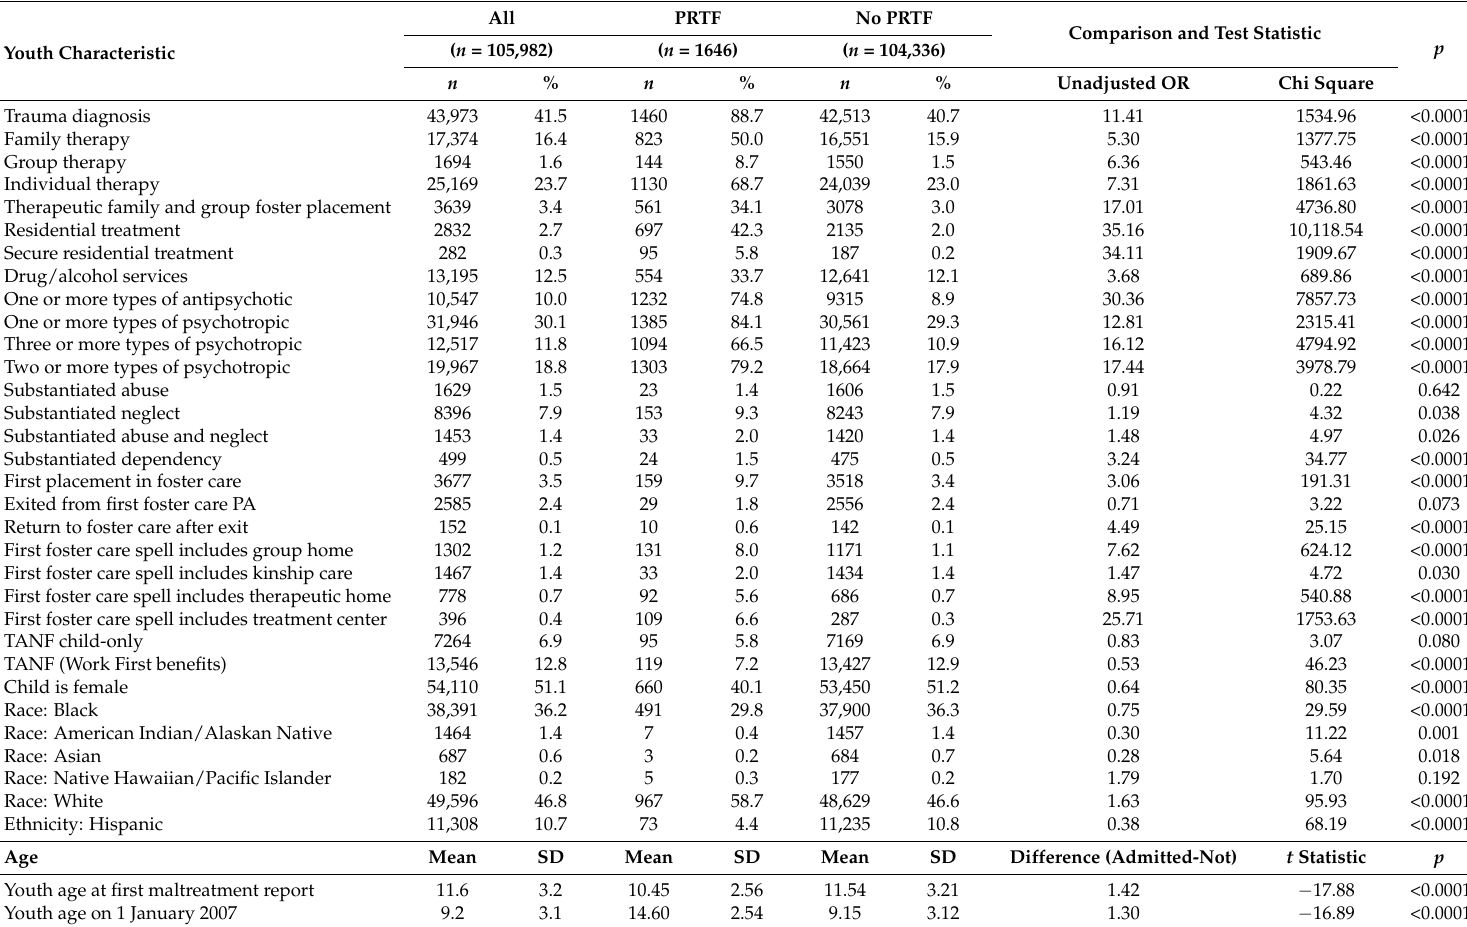
Table 1. Description of the study sample with bivariate analyses comparing children with and without later PRTF